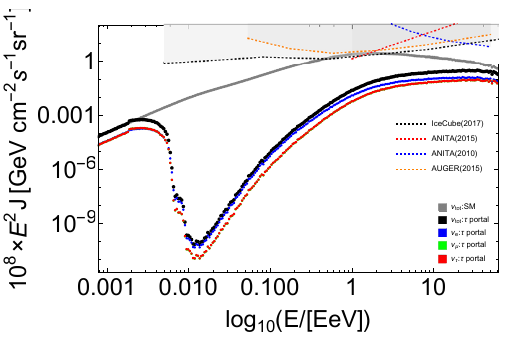
Figure 2. The flux ν µ (Green), ν τ (red) as a function of energy. For comparison, flux E 2 of total neutrinos within the SM is also shown (gray). We × take M ψ = m φ (shaded regions) at 90% CL are adapted from [14–17].